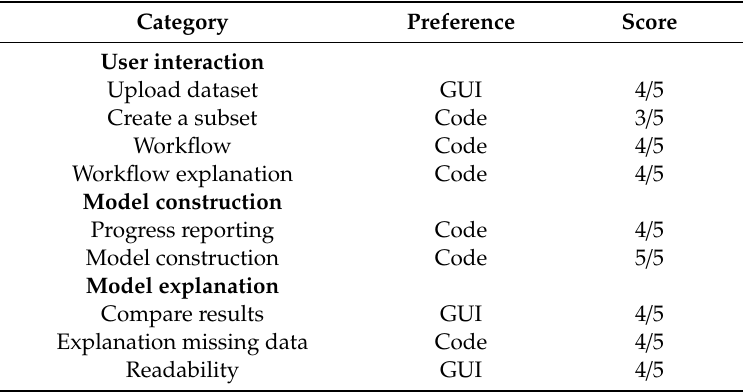
Table 4. Artefact preferences of the five domain